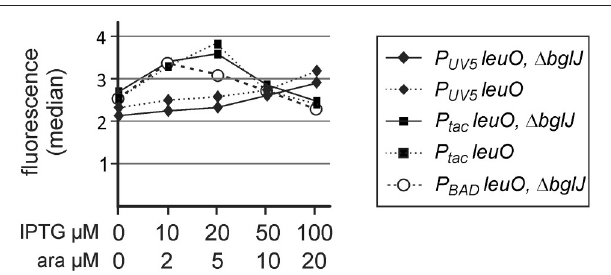
FIGURE 3 | Autoregulation of leuO transcription. Fluorescence expression levels directed by the P leuO mVenus fusion were determined by flow cytometry. The P leuO mVenus reporter strains U69 carrying a deletion of bglJ ( 1 yjjP-yjjQ-bglJ ) and its isogenic wild-type bglJ + derivative U95 were transformed with plasmids pKETS25 (pSC- ori ) that carries leuO under control of P UV 5 , pKEHB27 (p15A- ori ) that carries leuO under control of P tac , and pKES303 (p15A- ori ) that carries leuO under control of P BAD . The fluorescence median is plotted against the inducer concentration. Expression was analyzed by flow cytometry after 5h of growth in trypton medium, IPTG, and arabinose were added at the indicated concentrations. Statistical analysis suggests that the difference in the expression level is not significant ( P >